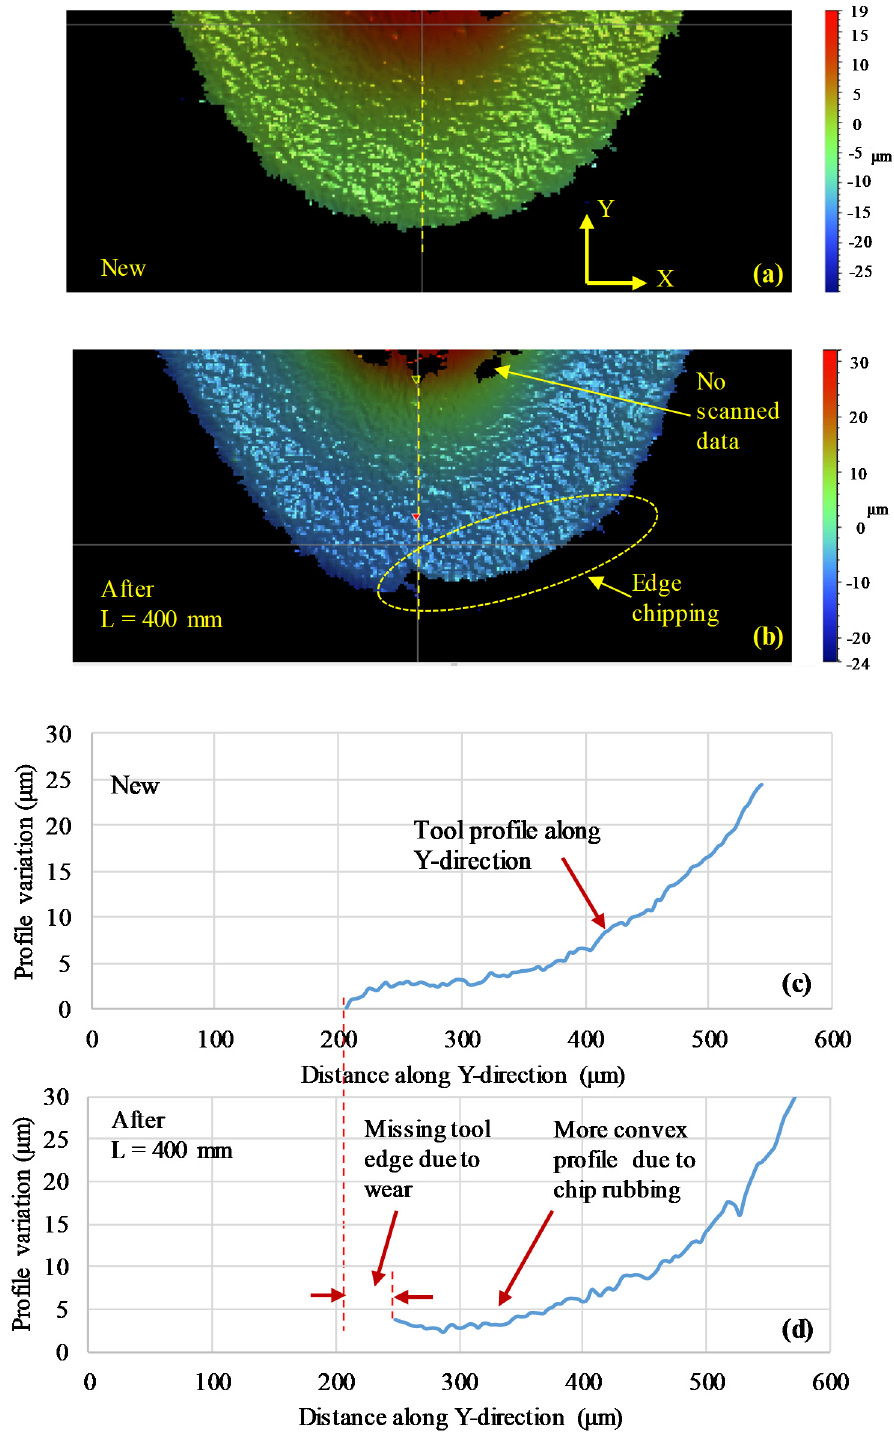
Figure 7. 3D scanned surfaces and 2D profiles of the conventional insert before and after use ( a ) 3D surface contour of a new insert; ( b ) 3D surface contour of a used insert after L = 400 mm; ( c ) 2D profile of new insert and ( d ) 2D profile of a used insert after L = 400 mm.